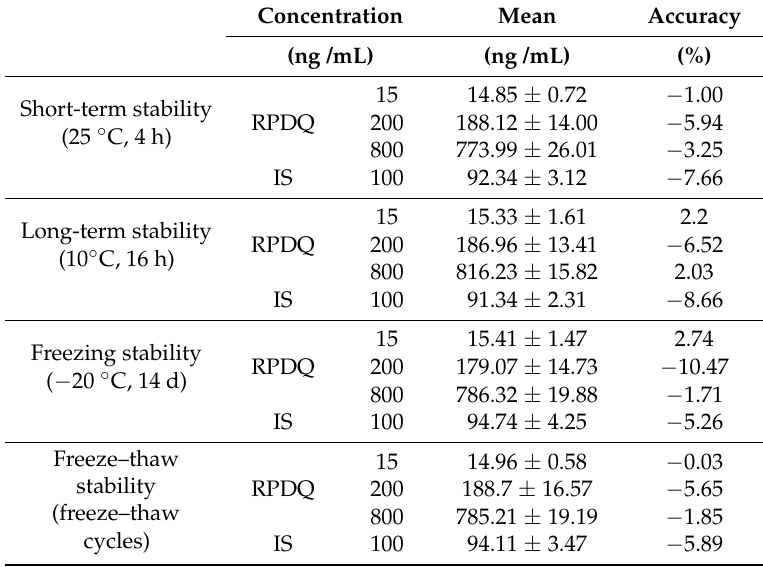
Table 2. The stability of RPDQ in rat plasma ( n = 6).